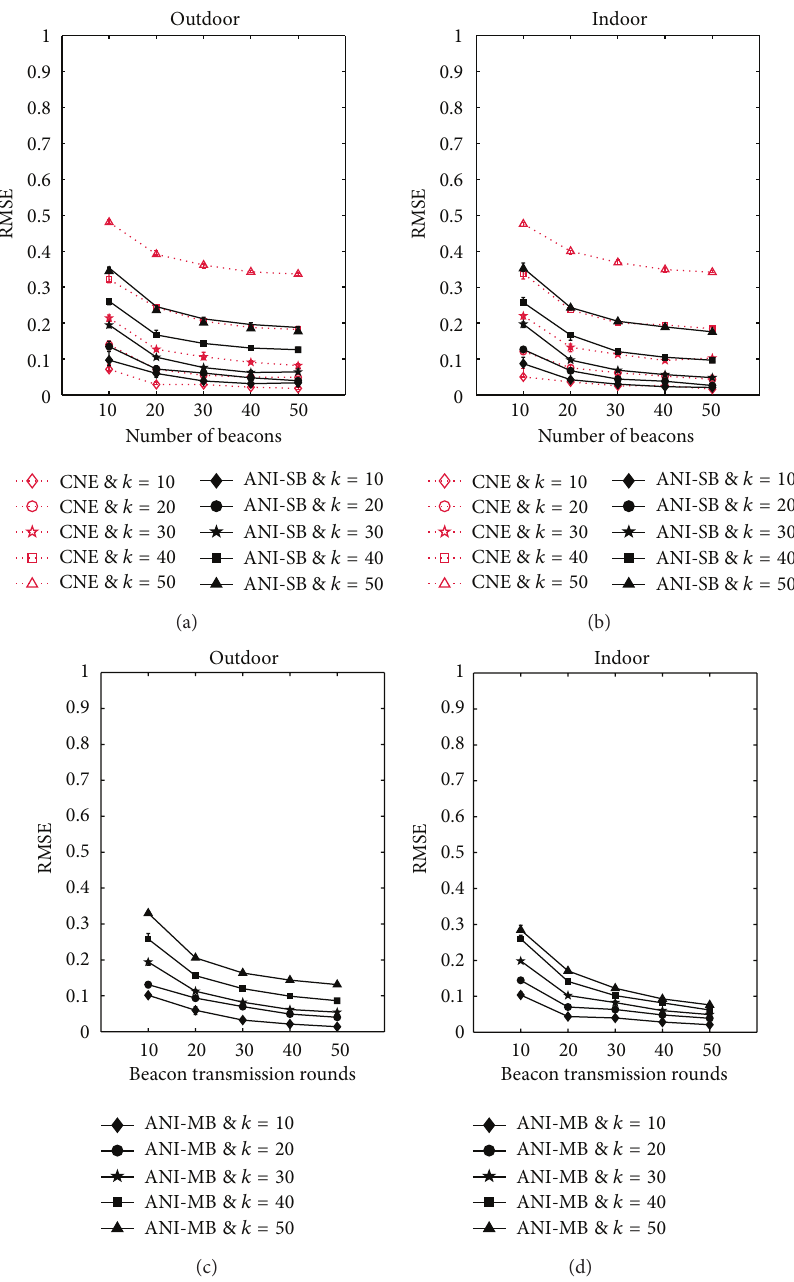
Figure 3: Link quality estimation errors by ANI-SB, ANI-MB, and CNE protocols in one-hop topology networks deployed in outdoor and indoor